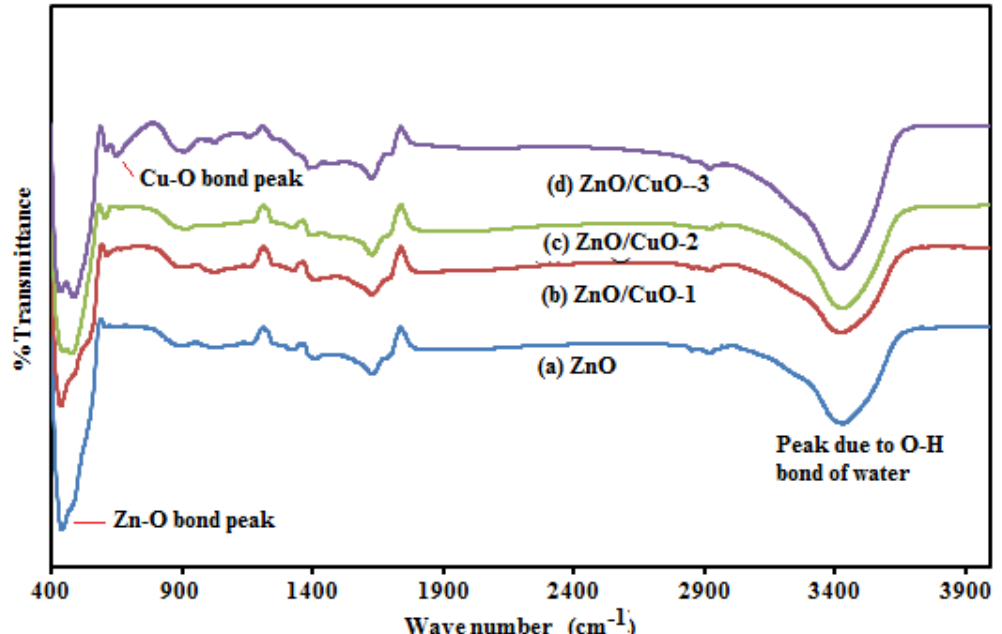
Fig.5. FTIR spectra of the prepared samples (a) ZnO nanoparticles (b) to (d) ZnO/CuO